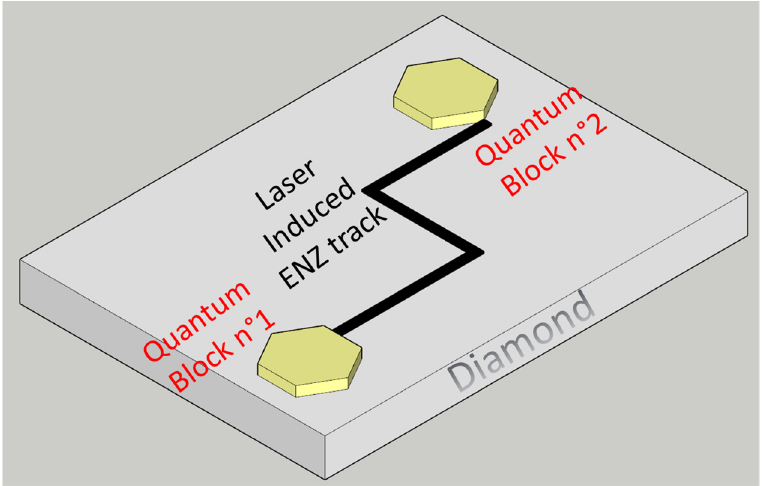
Figure 2. Sketch of the possible combination of quantum blocks on diamond substrates through spatially controlled laser induced ENZ waveguides.